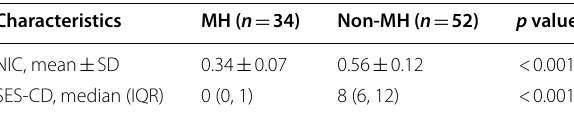
Table 3 NIC and SES-CD of patients with or without MH